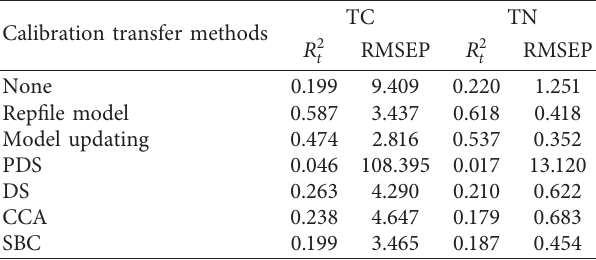
Figure 4: The spectral data of normal spectrometer and hyperspectral camera for soil samples (a) with poor nutrient concentration (TC: 1.9mg/kg; TN: 0.21mg/kg), (b) with poor nutrient concentration by SNV, (c) with rich nutrient content (TC:12.19 mg/kg; TN:1.74mg/kg), and (d) with poor and rich nutrient concentration by SNV. Table 5: Prediction results of soil TC and TN concentration by different calibration transfer algorithms after SNV spectral